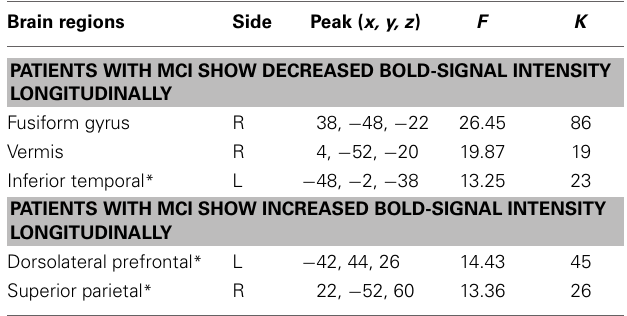
Table 3 | Group-by-time interaction effects in BOLD-signal intensity between patients with Parkinson’s disease with and without MCI. Brain